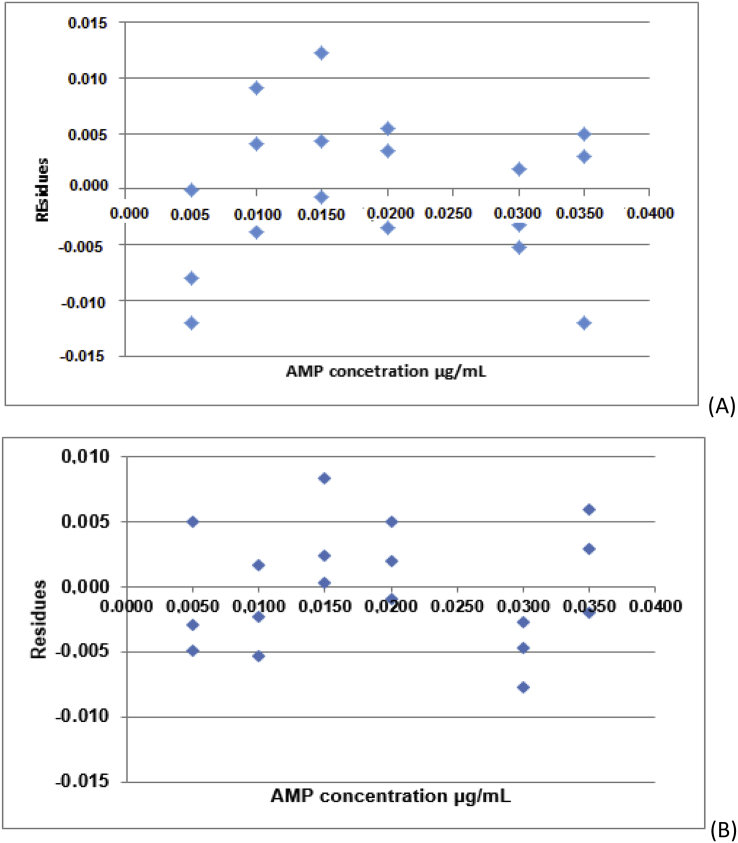
Graphics of residues (regression of residues versus AMP concentration levels) by Jacknife standardized residuals test. (A) AMP in the absence of the matrix and (B) AMP in the presence of the matrix (compounds of the nanoparticles).